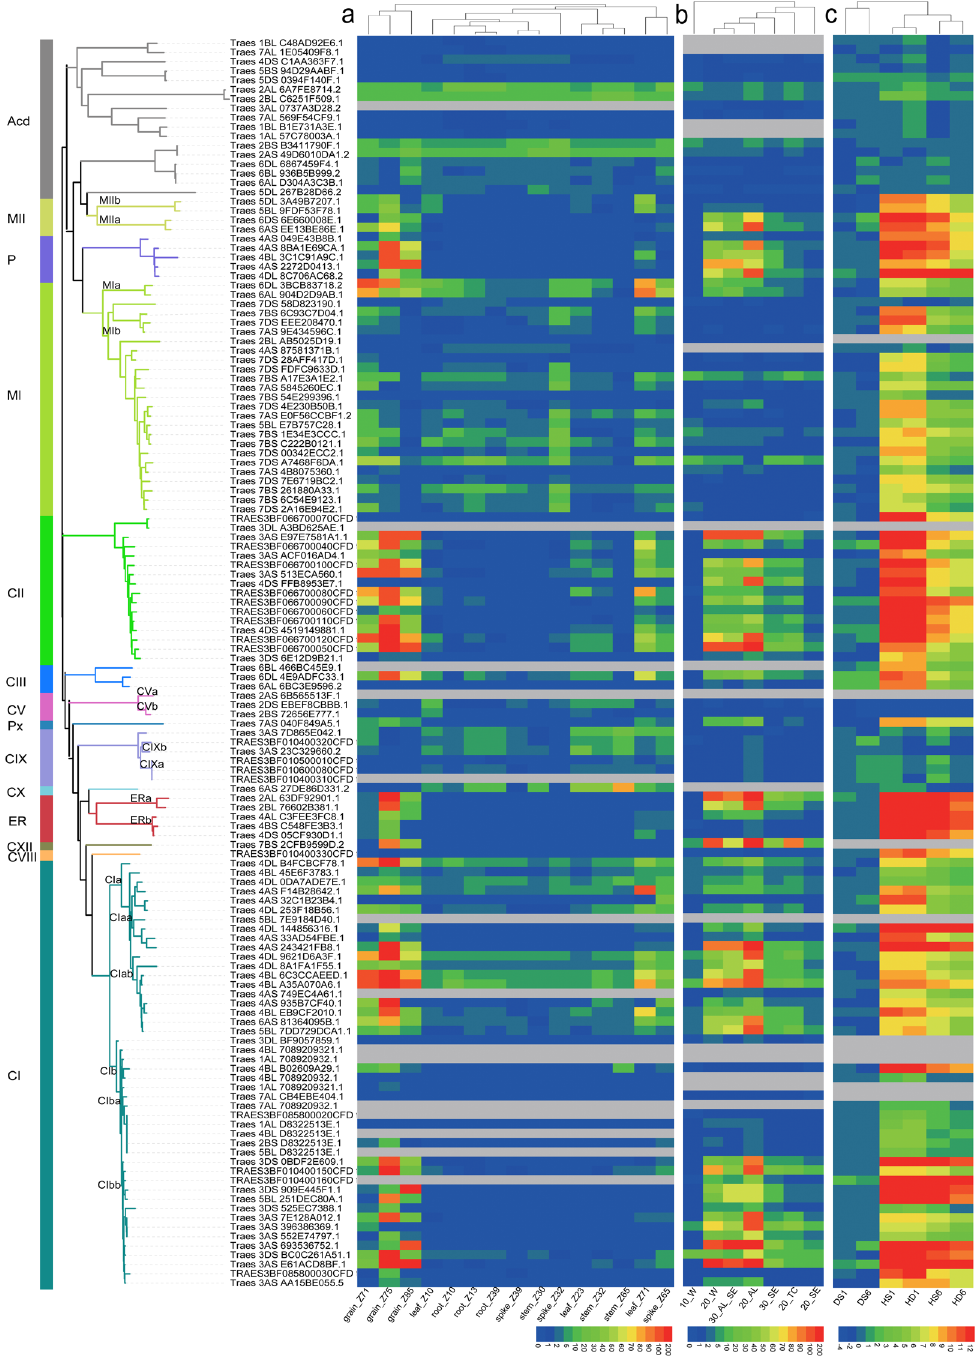
Figure 6. Phylogenetic tree of wheat sHSP genes and their expression profiles. The phylogenetic tree of wheat sHSP and Acd (that shared homology with the ACD domain of sHSPs but diverged from sHSPs) genes is shown on the left side of the panel. The clades of each subfamily are depicted by specific colours, and the names of subfamilies are marked to the left. The symbols of duplicated groups derived from Supplementary Fig. S4 were marked at the leading clades of each group. ( a ) The expression profiles were estimated using RNA-seq data from five organs at three developmental stages. Transcript levels are depicted using a colour scale indicating FPKM (fragments per kilobase of exon model per million mapped reads) values. The symbols representing development stages were as previously reported 31 . ( b ) The expression profiles were estimated using RNA-seq data from different grain cell types at three developmental stages. Transcript levels are depicted using a colour scale indicating the FPKM values. The symbols representing cell types and developmental stages were as previously reported 29 . ( c ) The expression profiles under heat (HS), drought (DS) and the combined stress of heat and drought (HS) after 1 and 6 h treatments 65 . Transcript levels are depicted using a colour scale indicating log 10 values. The grey lines in panels a, b and c indicate that the sHSP genes were not detected in the corresponding RNA-seq